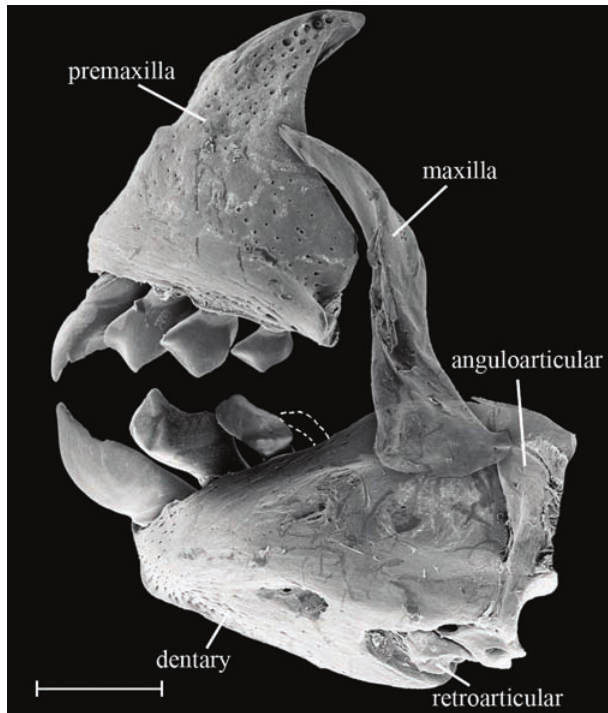
Fig. 2. SEM image of jaws of Leporinus jamesi , lateral view, MZUSP 75639, 89.0 mm SL. The dotted line indicates a fourth tooth that is normally present, but that was lost during preparation of the specimen. Scale bar = 1 mm.